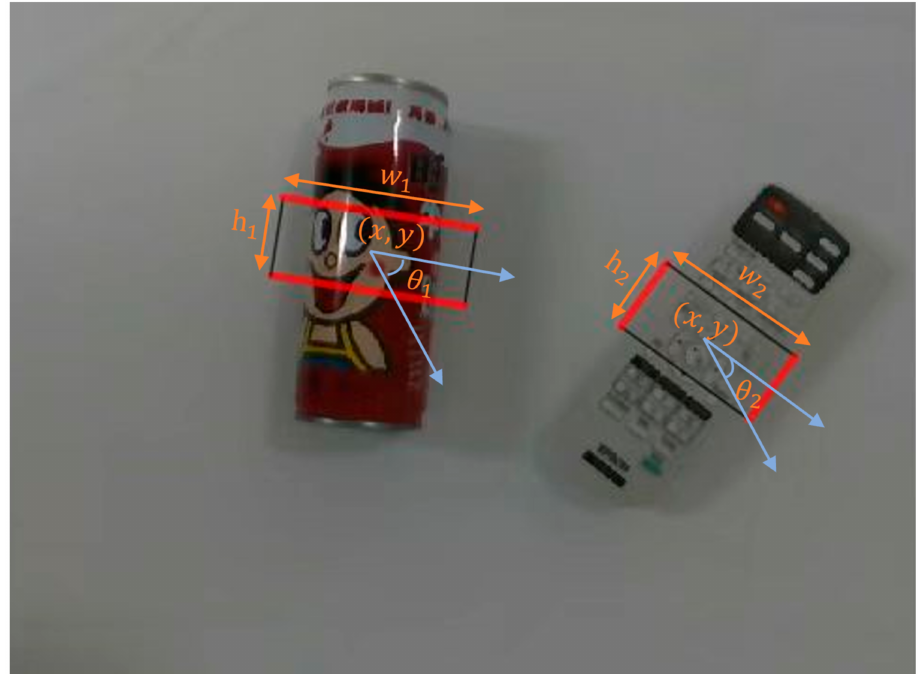
Figure 2. The representation of grasping box. Where ( x , y ) is the box’s centre. W and h represent the length and width of the grasping box. θ is the angle formed by the grasping box and the horizontal axis of the